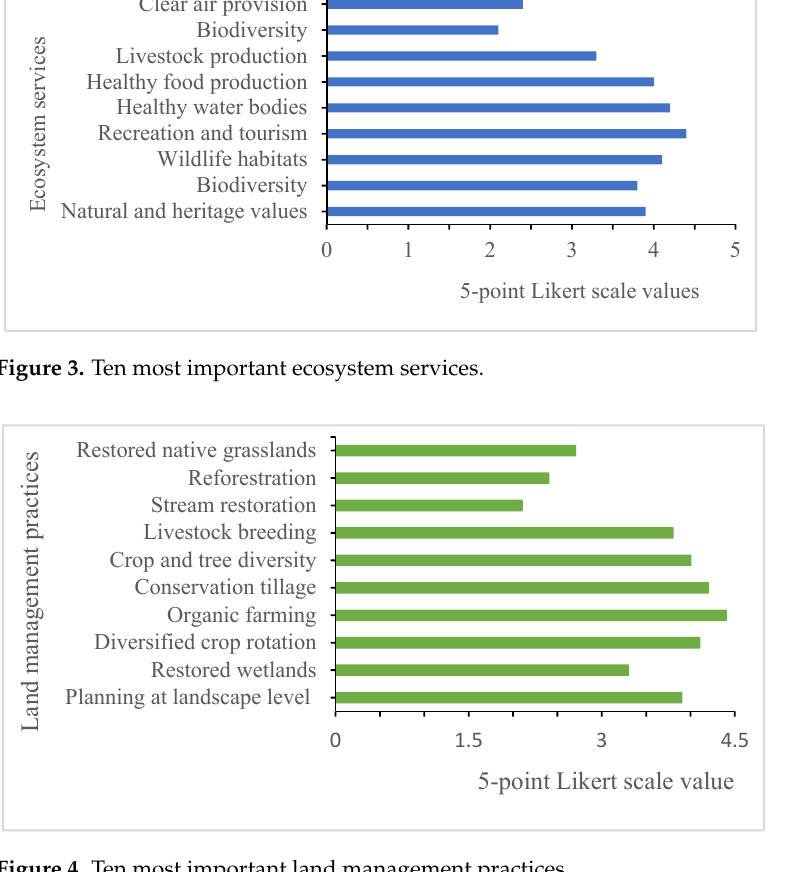
Figure 3. Ten most important ecosystem services.